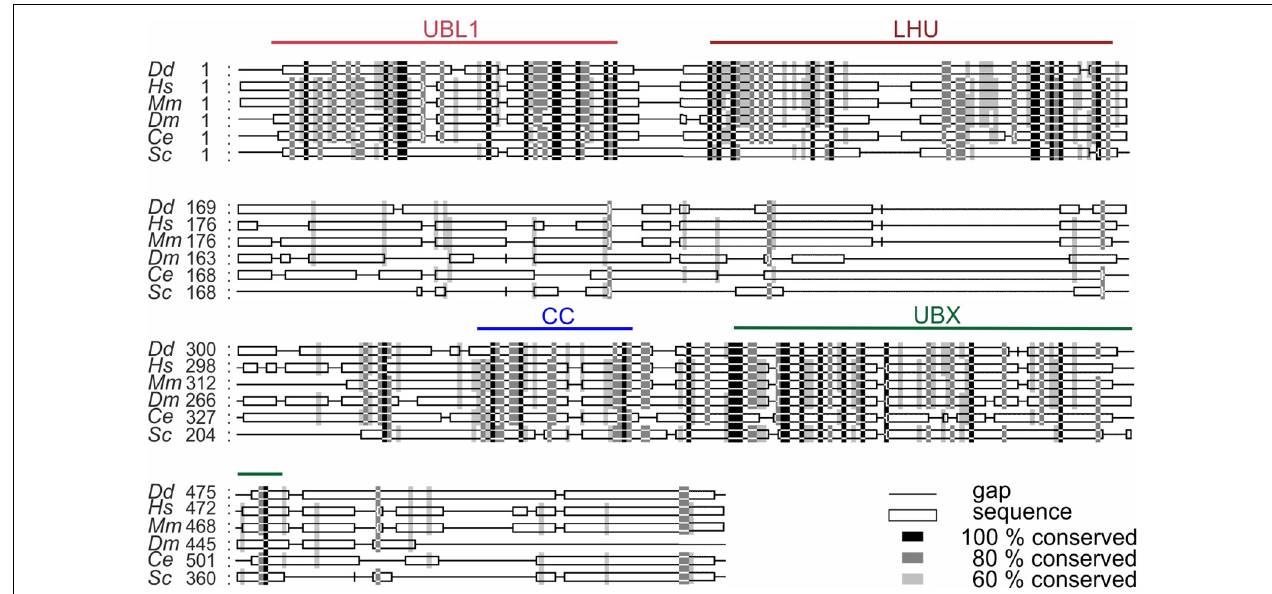
FIGURE 2 | Sequence alignment of UBXD9 proteins from different model organisms. A multiple sequence alignment of UBXD9 protein sequences from D. discoideum ( Dd), H. sapiens (Hs), Mus musculus (Mm), Drosophila melanogaster (Dm), Caenorhabditis elegans (Ce), and S. cerevisiae (Sc) was generated with Clustal Omega (Version 1.2.4; Goujon et al., 2010; Sievers et al., 2011) and then edited with Gendoc (v0.7.2). Genbank accession numbers are: ( Dd ) XP_641771, (Hs) NP_076988, ( Mm ) NP_081153, ( Dm ) NP_001027152, ( Ce ) NP_505652, ( Sc ) EWG89362. Shading reflects sequence conservation. The domain organization is homologous in all species and sequence conservation is high in the specified domains. UBL1, Ubiquitin-like domain 1; LHU, Low Homology UBX domain; CC, Coiled coil domain; UBX, Ubiquitin regulatory X domain. Numbers indicate amino acid positions.